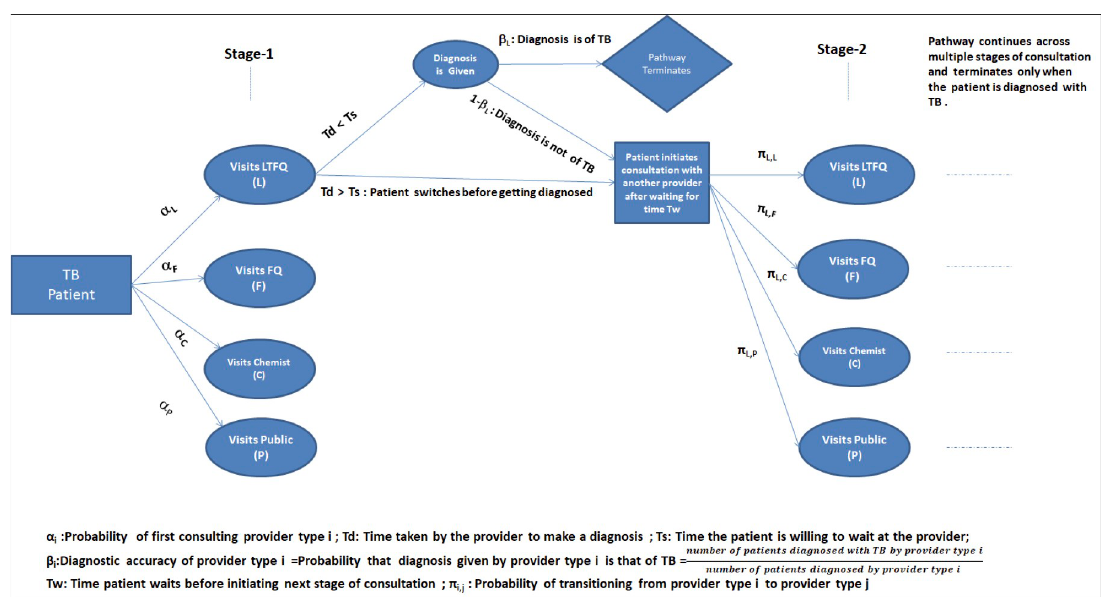
Fig 1. Schematic representation of the simulation model. FQ, fully qualified provider; LTFQ, less-than-fully-qualified provider; TB, tuberculosis.